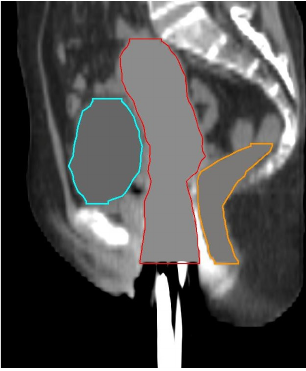
Figure 1. An example of sagittal BT image after preprocessing. The cyan, orange, and red contours represent bladder, rectum, and U + V, respectively.